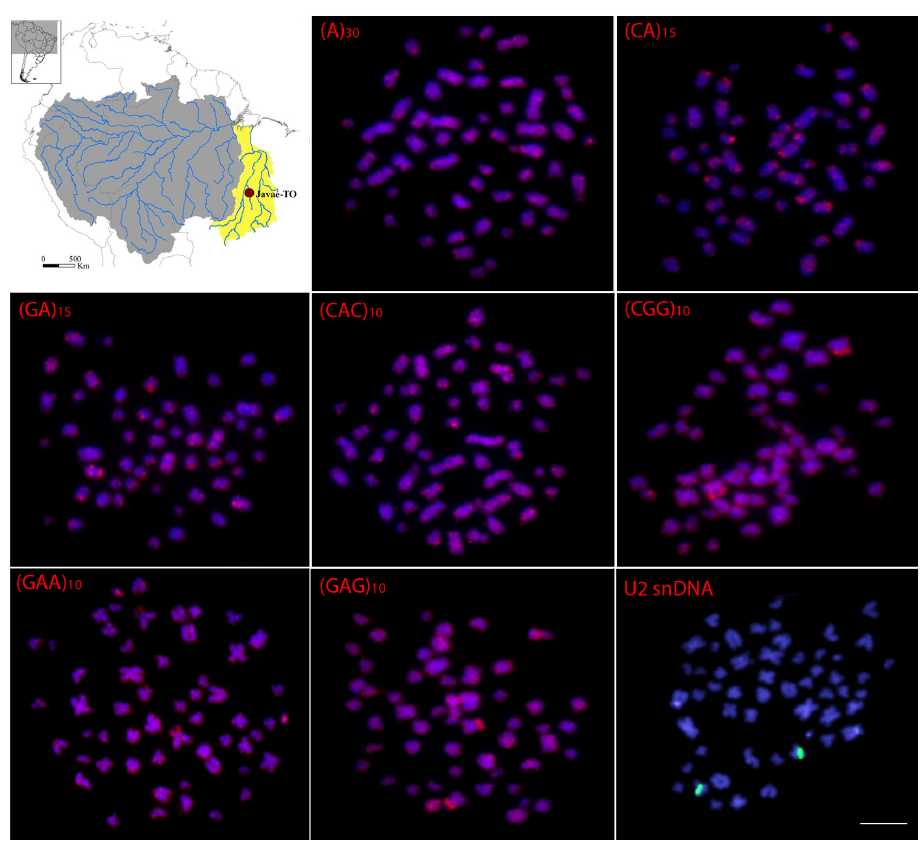
FIGURE 3 | Metaphase plates of Arapaima gigas from Javaé (JAV) population (Araguaia-Tocantins River basin) hybridized with repetitive DNA sequences, including mono-, di- and trinucleotide microsatellites and the multigene families U2 snDNA. Bar=5